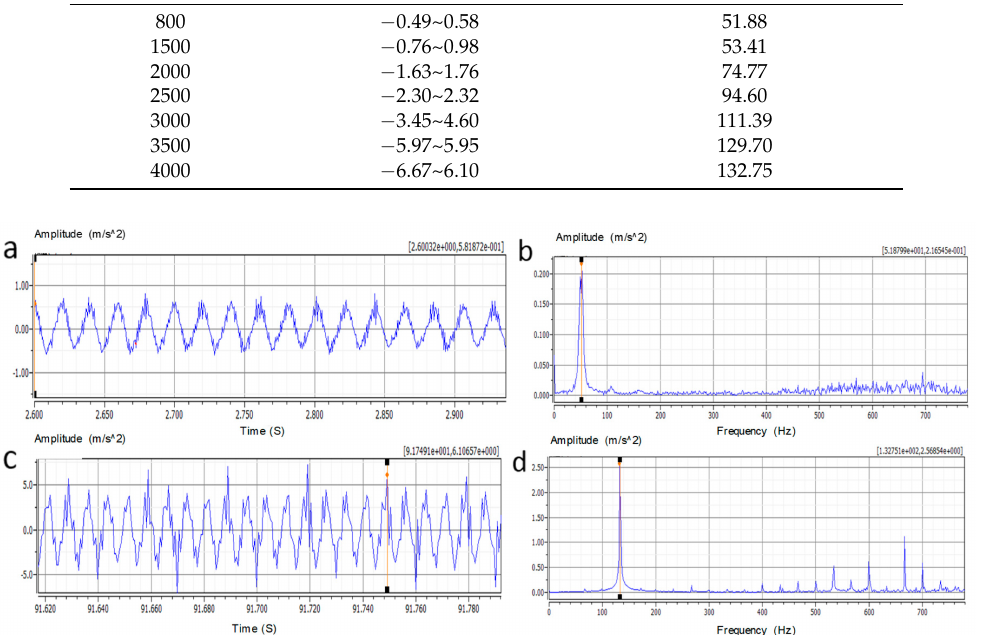
Figure 1. ( a , b ) The vibration signal in Z direction on the cylinder head of the 2HO engine at 800 r/min in time and frequency domain; ( c , d ) The vibration signal in Z direction on the cylinder head of the 2HO engine at 4000 r/min in time and frequency